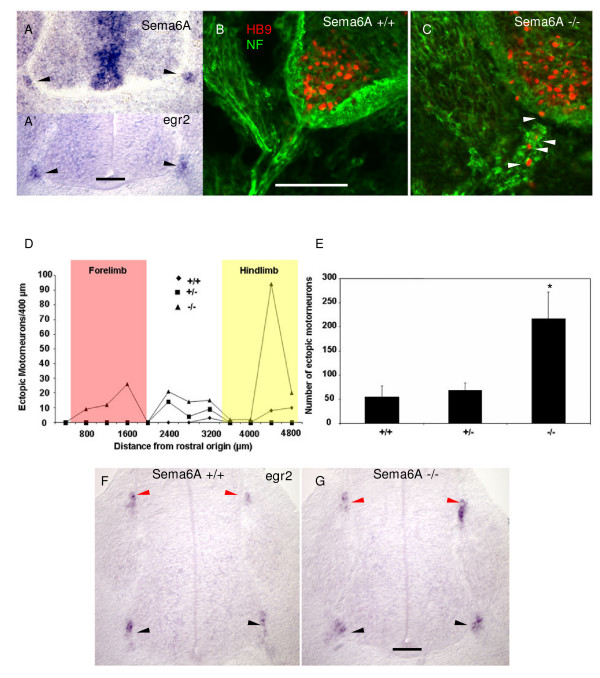
Genetic ablation of Sema6A in BC cells leads to ectopic migration of motor neurons. (a) In situ hybridisation shows expression of Sema6A in BC cells at the MEP (black arrows) in transverse cryosections of E12 mouse embryos. Expression of egr2/krox-20 in an adjacent section (a') confirms the signal in (a) corresponds to BC cells. Bar = 100 μm. (b,c) Dual immunostaining of transverse cryosections of E13.5 Sema6A mouse embryos. Compared with wild-type littermates (b) where HB9 positive motor neuron somata (red) are exclusively confined to the ventral spinal cord, in Sema6A null embryos (c) many motor neurons can be seen in ectopic positions in the neurofilament-positive (green) presumptive white matter and ventral nerve roots. Bar = 100 μm. (d) A quantitative analysis of the distribution of HB9-positive ectopic motor neurons along the rostro-caudal axis of E13.5 mouse spinal cord shows a distinct peak at hindlimb level (yellow box) but not forelimb level (red box) in null (triangles) compared with heterozygous (squares) and wild-type (diamonds) embryo littermates. (e) A comparison of the cumulative counts of HB9 positive ectopic motor neurons in sections from posterior trunk (hindlimb containing) region of E13.5 Sema6A wild-type, heterozygous and null embryos. Consistent with the quantitative analysis shown in (d), there is a significant increase (p = 0.03; two-tail t-test) in ectopic motor neurons in the hindlimb region of Sema6A null mice (n = 4 each). (f,g) In situ hybridisation for egr2/krox-20 on transverse cryosections (30 μm) of E11.5 mouse embryos at hindlimb level. The results show no obvious difference in Egr2 expression at the DREZ or MEP in wild-type (f) or Sema6A null mice (g), indicating that formation of boundary caps is not perturbed by genetic ablation of Sema6A. Bar = 100 μm. *P ≤ 0.05; two-tailed t-test